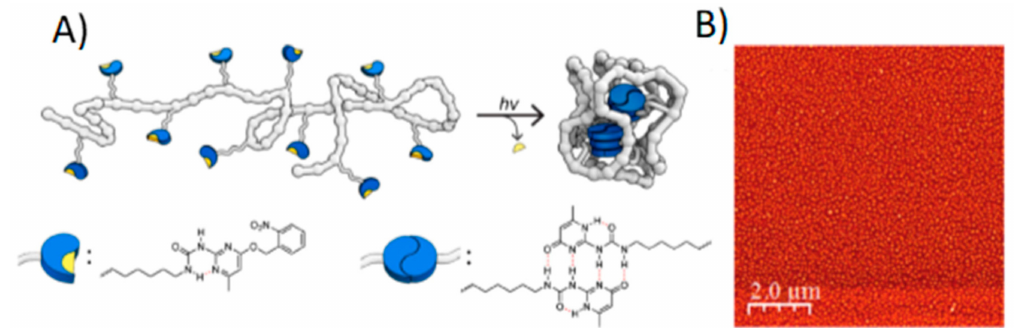
Figure 11. Schematic illustration of the synthesis of reversible, non-covalent bonded SCNPs via photodeprotection of o-nitrobenzyl-substituted 2-ureido-pyrimidinone (UPy) moieties, followed by UPy dimerization via quadruple hydrogen bonding interactions, ( A ) and an AFM picture of the resulting SCNPs ( B ). Reprinted from [44] with permission.